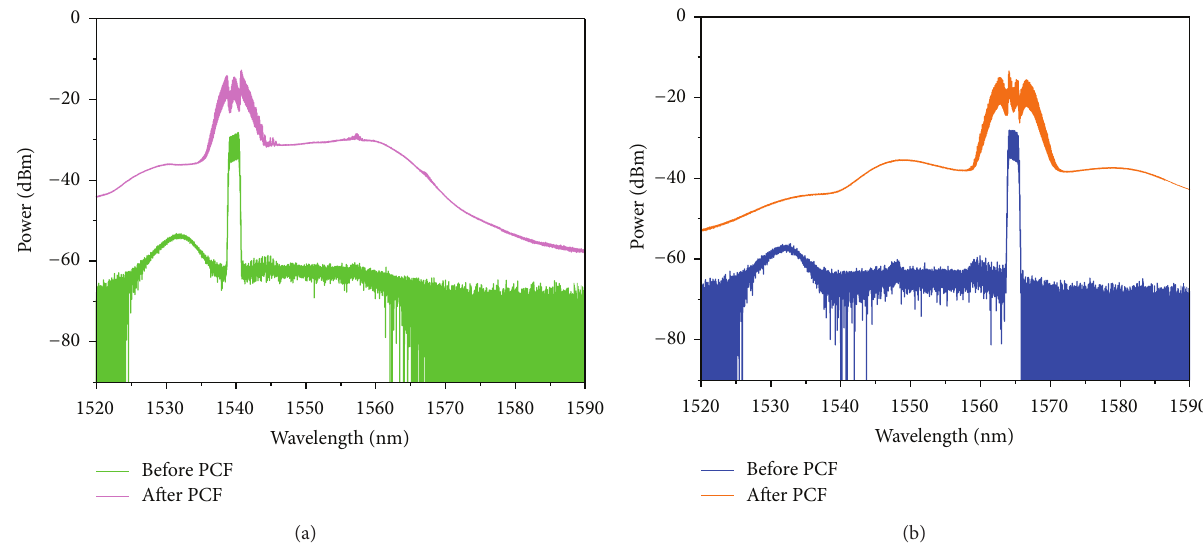
Figure 7: Optical spectrum measured at the input and the output of 100m DF-HNL-PCF for (a) 𝜆